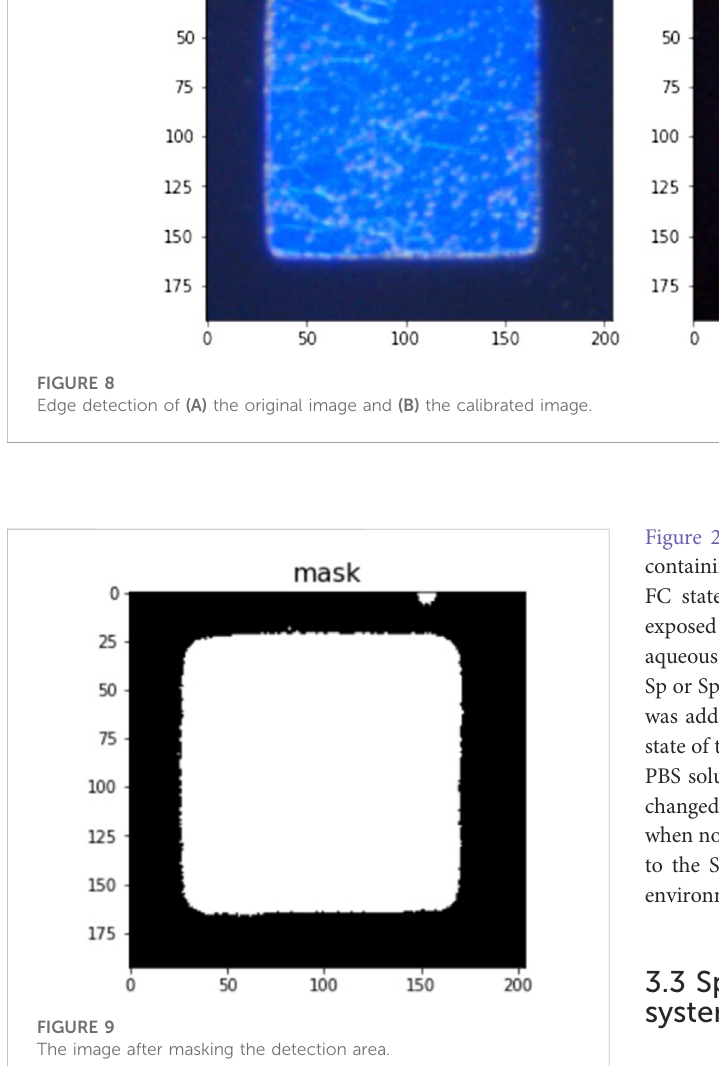
FIGURE 9 The image after masking the detection